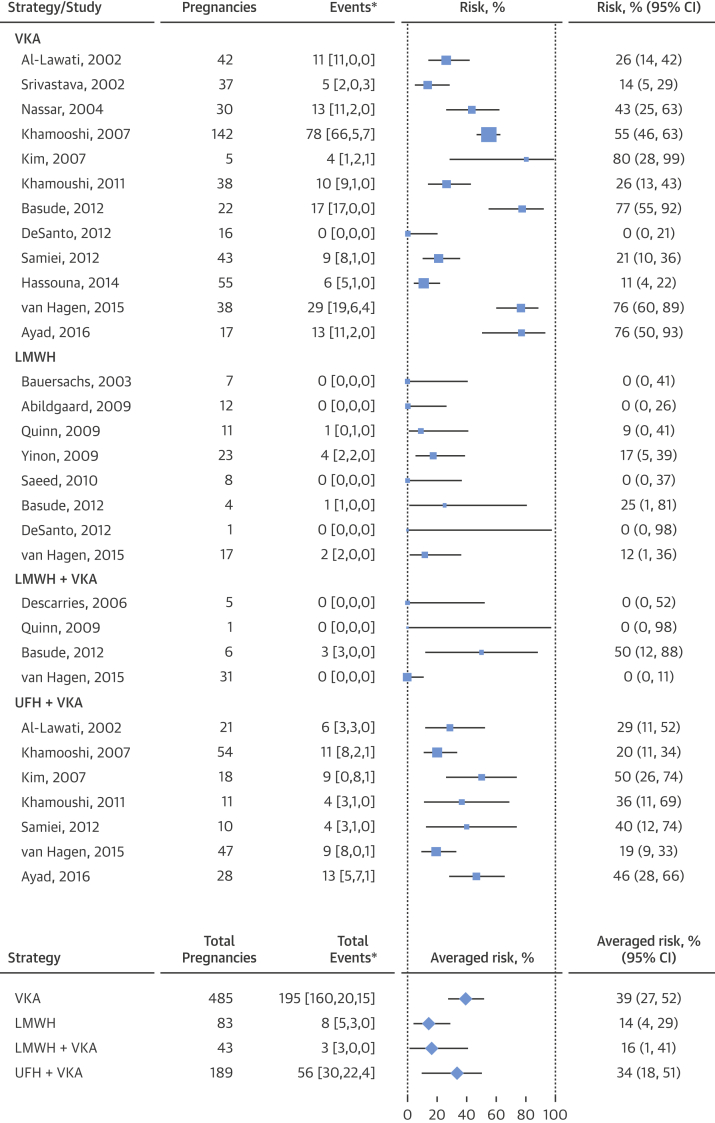
Forest Plot of the Composite Fetal OutcomeThe individual and composite fetal endpoints as reported by each publication included in the meta-analysis. The forest plot represents an averaged risk of the composite outcome, weighted by study sample size. *Values in brackets are number of spontaneous abortions, number of fetal deaths, number of births with congenital defects. Abbreviations as in Figures 1 and 2.